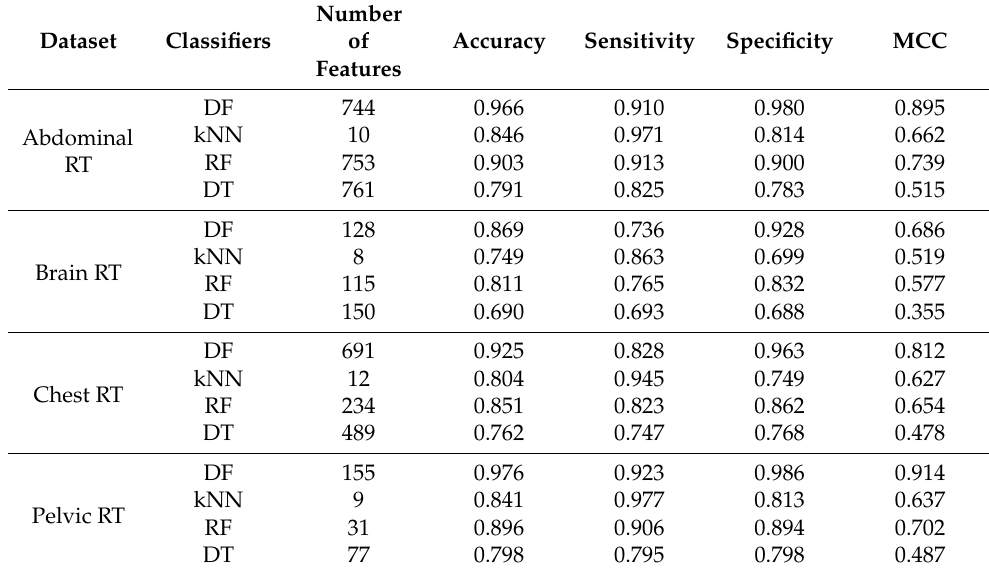
Table 2. Detailed performance of different classifiers on four methylation